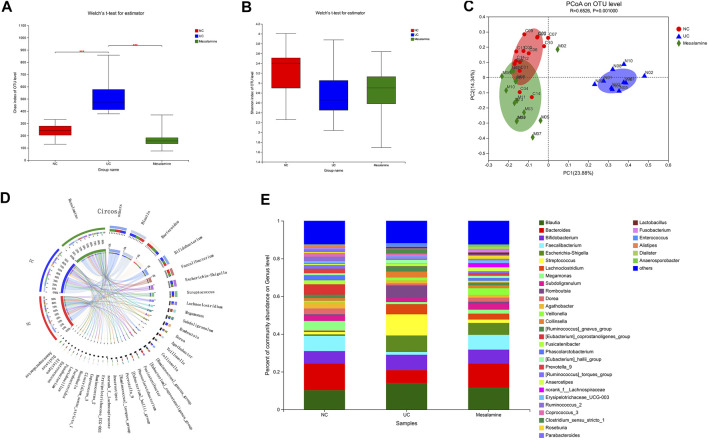
Gut microbiota diversity and composition analysis. (A) α-Diversity evaluated by Chao index (***p < 0.001) (B). α-Diversity evaluated by Shannon index. (C) PCoA plots based on unweighted UniFrac distance (D). Diagram of Circos analysis, the small semicircle (left half circle) represents the species composition in the sample, the color of outer ribbon represents the group from which the species came, the color of inner ribbon represents the species, and the length represents the relative abundance of the species in the corresponding samples; the large semicircle (right half circle) represents the distribution proportion of species in different samples at the taxonomic level, and the outer layer ribbon represents the species, the inner ribbon color represents different groups, and the length represents the distribution proportion of the sample in a certain species. (E) The overall percentage of gut microbiota community abundance on genus level.